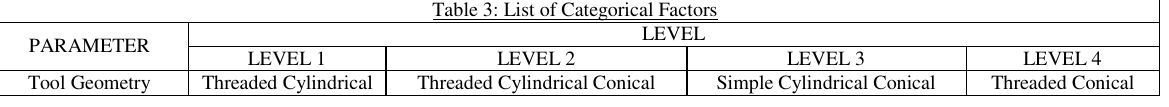
Table 3: List of Categorical